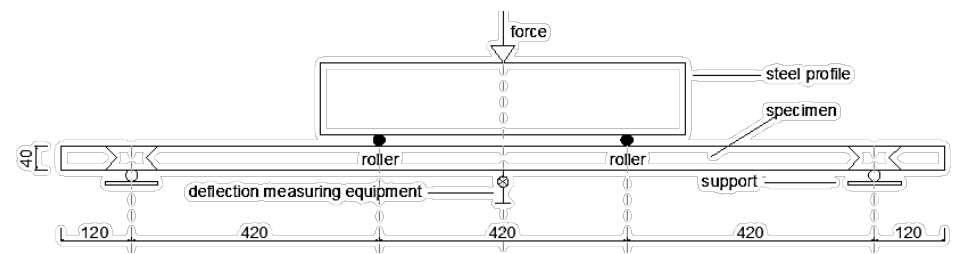
Figure 1. Experimental design (dimensions in mm).